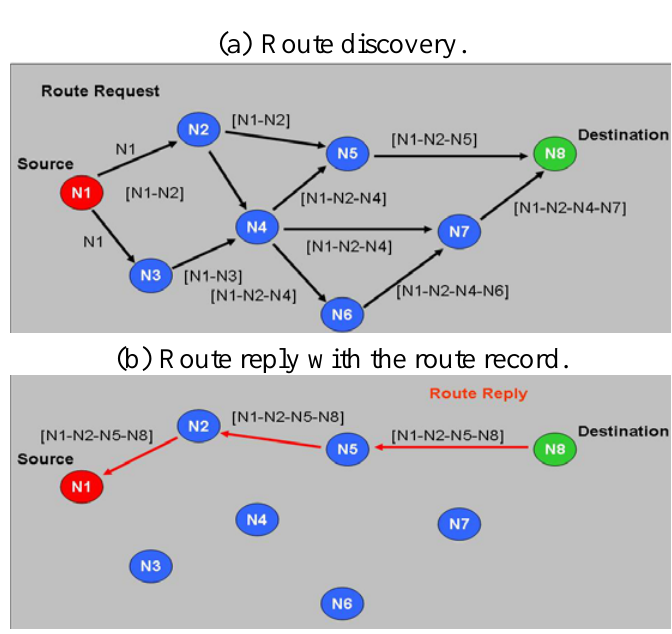
Figure 3. DSR routing operations.